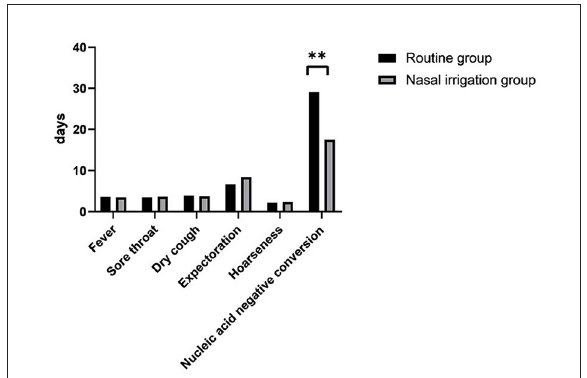
FIGURE1 Time to the disappearance of symptoms and conversion of nucleic acids. Between the routine treatment and nasal irrigation groups. ** P < 0.01.